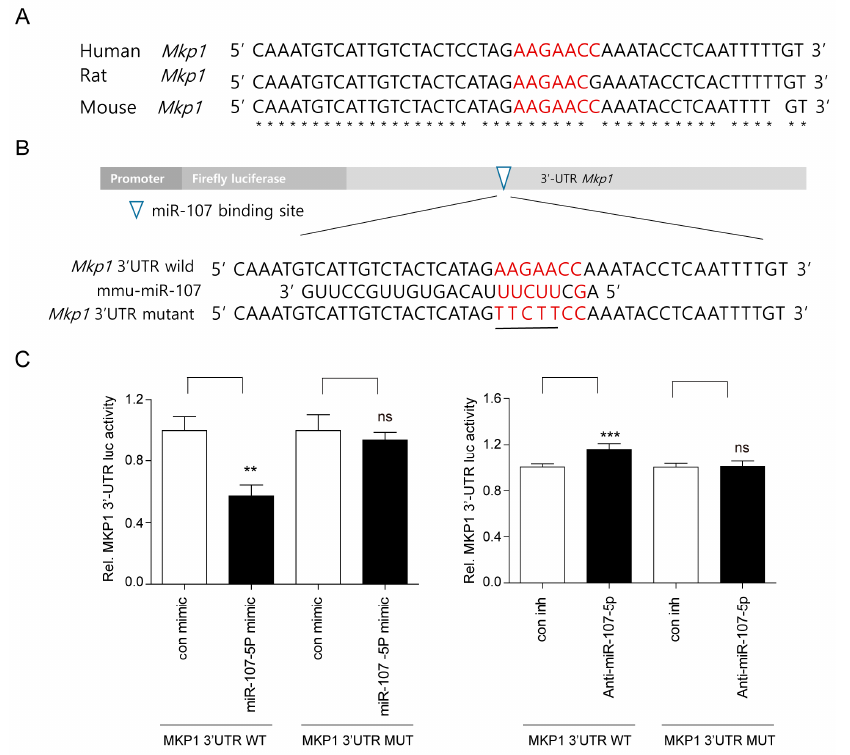
Figure 4. MiR-107-5p specifically targets MKP1 by binding to the 3 (cid:48) -untranslated region (UTR) of MKP1. ( A ) The target site of miR-107-5p in 3 (cid:48) -UTR of MKP1 is conserved in humans and rodents (indicated with asterisks). ( B ) The 3 (cid:48) -UTR mutants of MKP1 are identical to the mouse 3 (cid:48) -UTR wild type (WT) of MKP1 except that it contains five single base substitutions (underlined in the figure) to disrupt pairing with mature miR-miR-107-5p (mmu-miR-107-5p). ( C ) The mouse 3 (cid:48) -UTR WT of MKP1 containing miR-107-5p binding sites or its mutated counterpart were cloned into a luciferase reporter vector and transfected into RAW264.7 cells with miR-107-5p mimic or anti-miR-107-5p with each corresponding control (n = 6). Luciferase assays were performed using a dual-luciferase reporter assay system. ** p < 0.01; *** p < 0.001 compared to its corresponding control; ns, not significant. Similar results were obtained in three independent